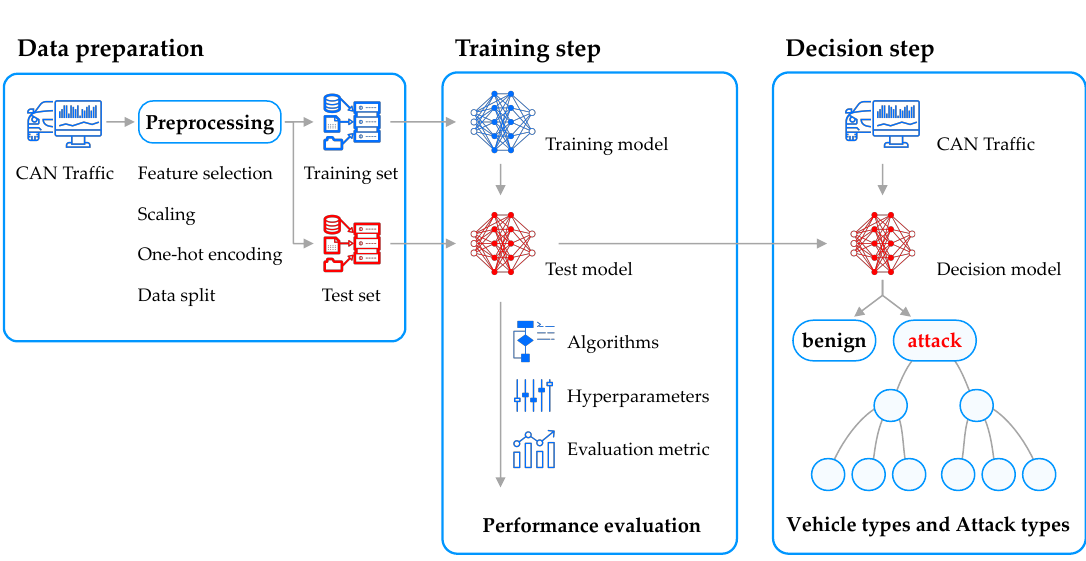
Figure 3. Overall multi-labeled hierarchical classification (MLHC) process.